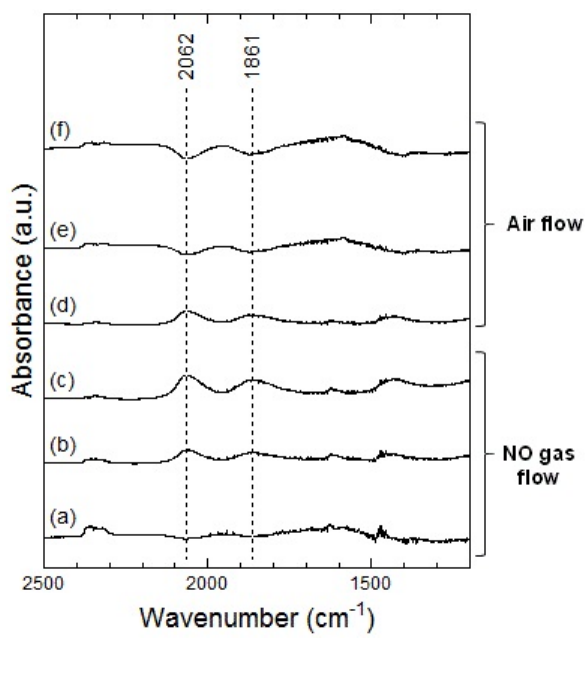
Figure 10. DRIFT spectra of WO powder at 200 °C. The powders were exposed to 1 ppm 3 of NO in air for ( a ) 2 min, ( b ) 20 min, and ( c ) 50 min. After NO exposure, the powders were purged by air for ( d ) 1 min, ( e ) 30 min, and ( f ) 60